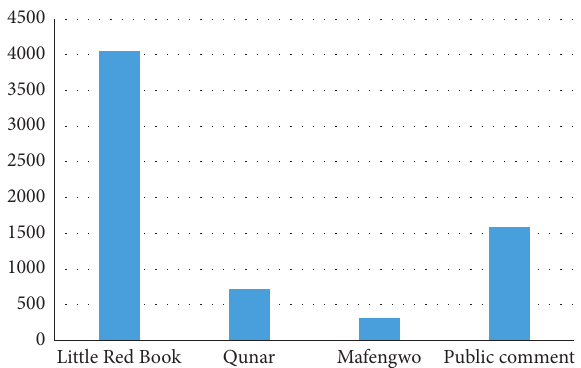
Figure 7: Raiders’ information distribution information of tourism platform.